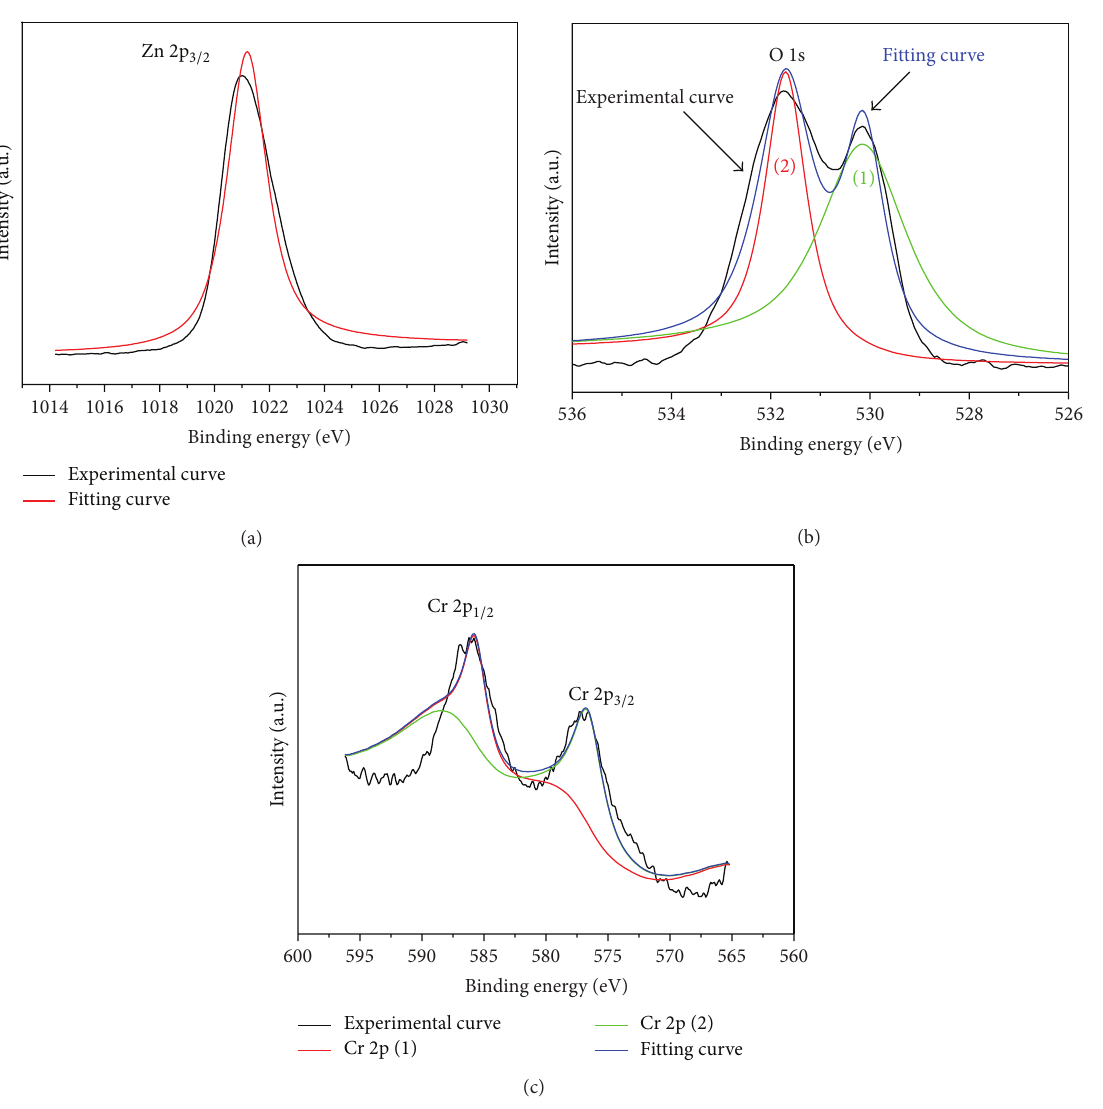
Figure 6: XPS spectrum of Cr-doped ZnO